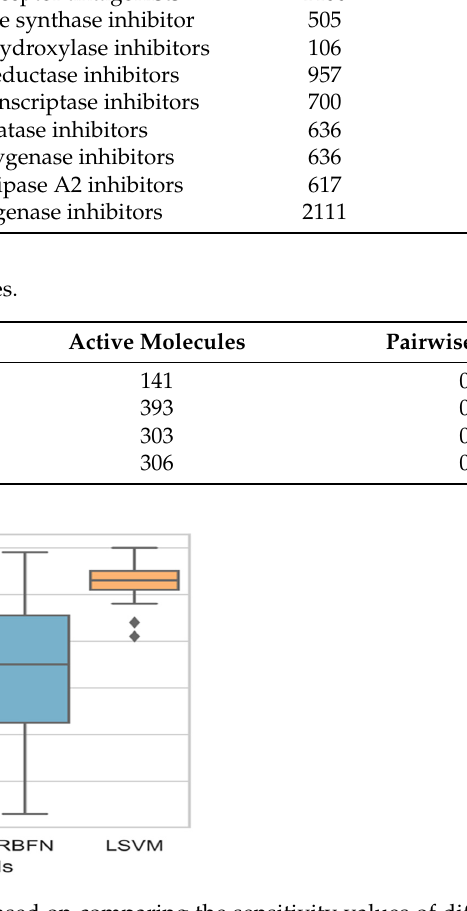
Figure 9. Boxplot chart results based on comparing the sensitivity values of different algorithms: CNNfp, NaiveB, RBFN, and LSVM.